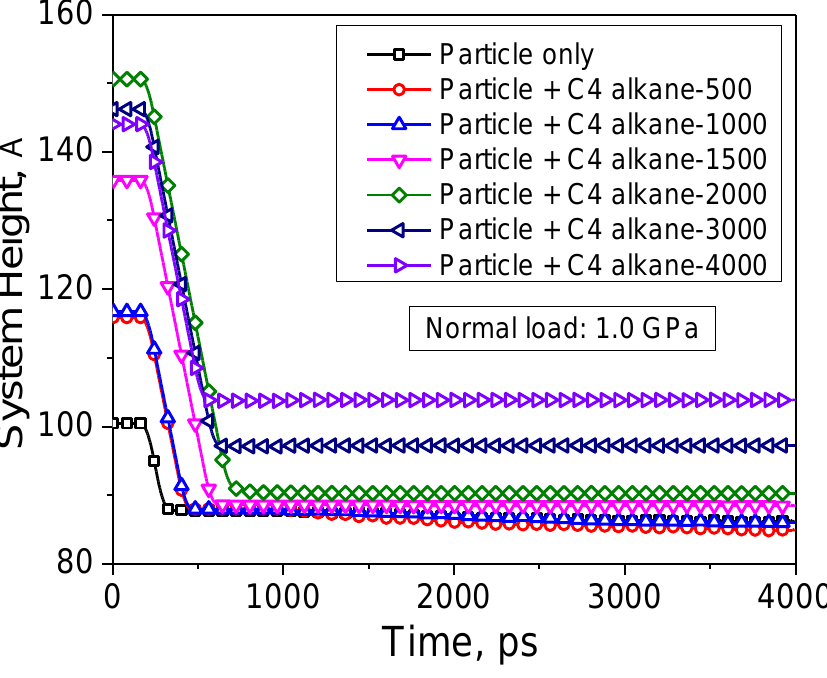
Figure 11. Comparison of the system height evolution history against the simulation time between the particle and lubricated models under the normal load of 1.0 GPa. The number of C4-alkane molecules varies from 500 to 4000.